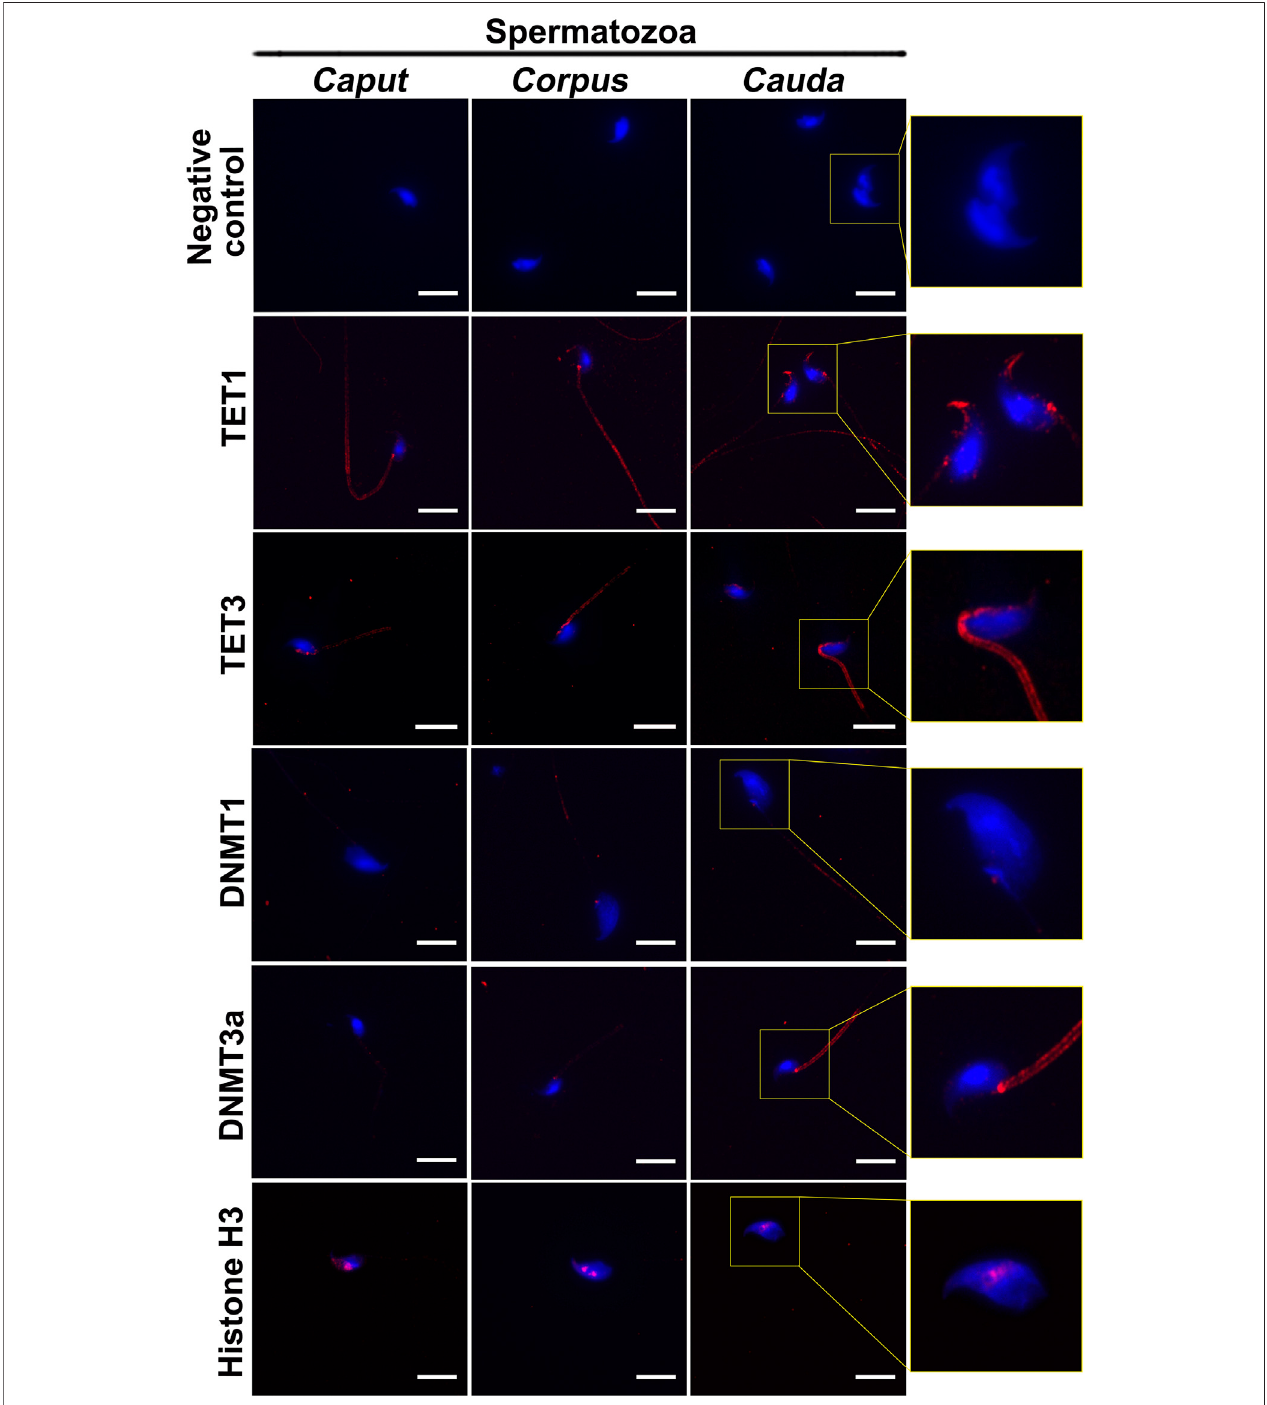
FIGURE7| Immuno fl uorescencedetectionofTET1,TET3,DNMT1,andDNMT3ainc aput,corpusandcauda spermatozoa.DetectionofHistoneH3wasusedas apositivecontrolforthedetectionofspermnucleicproteins(arrow).Omissionofprimaryantibodieswasusedasanegativecontrol.Insets(yellowsquares)represent×2 magni fi cation of spermatic heads. Results are representative of three independent experiments. Scale bar: 10 μ m.